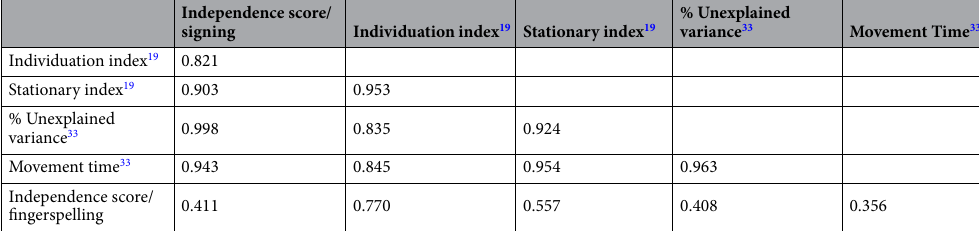
Table 1. Correlation coefficients (rs) of correlations between different measures of digit